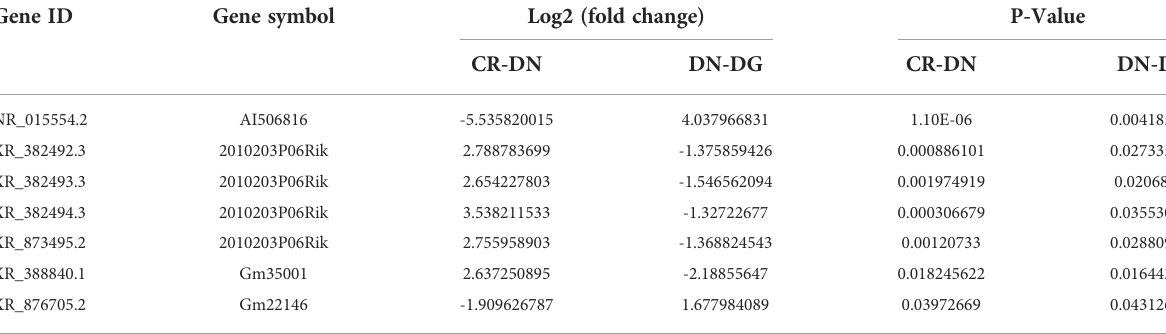
TABLE 1 The differentially expressed LncRNAs in the three groups.